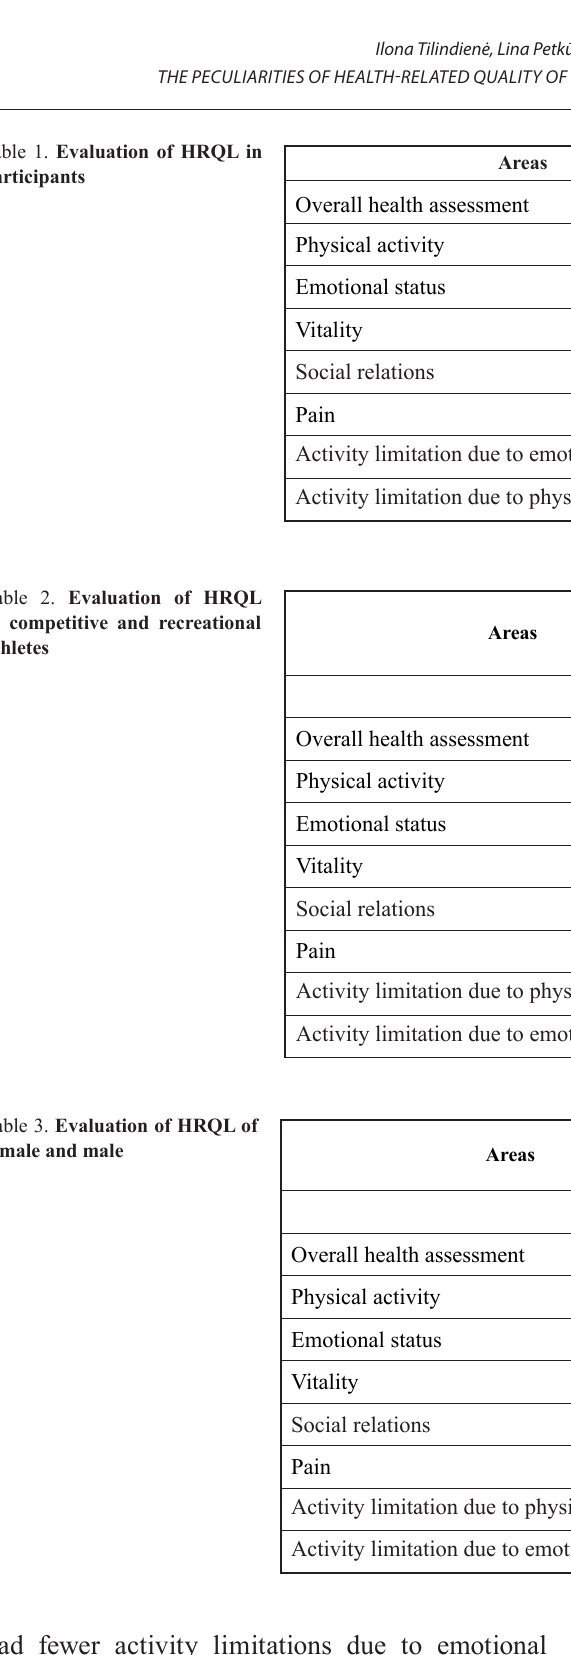
due to emotional difficulties. Men evaluated their social relationships better than women ( U = 250, p = .00) and had fewer activity limitations due to emotional difficulties than women ( U = 335, p = .00). Analysis of HRQL of competitive athletes showed no statistically significant relationship between women and men